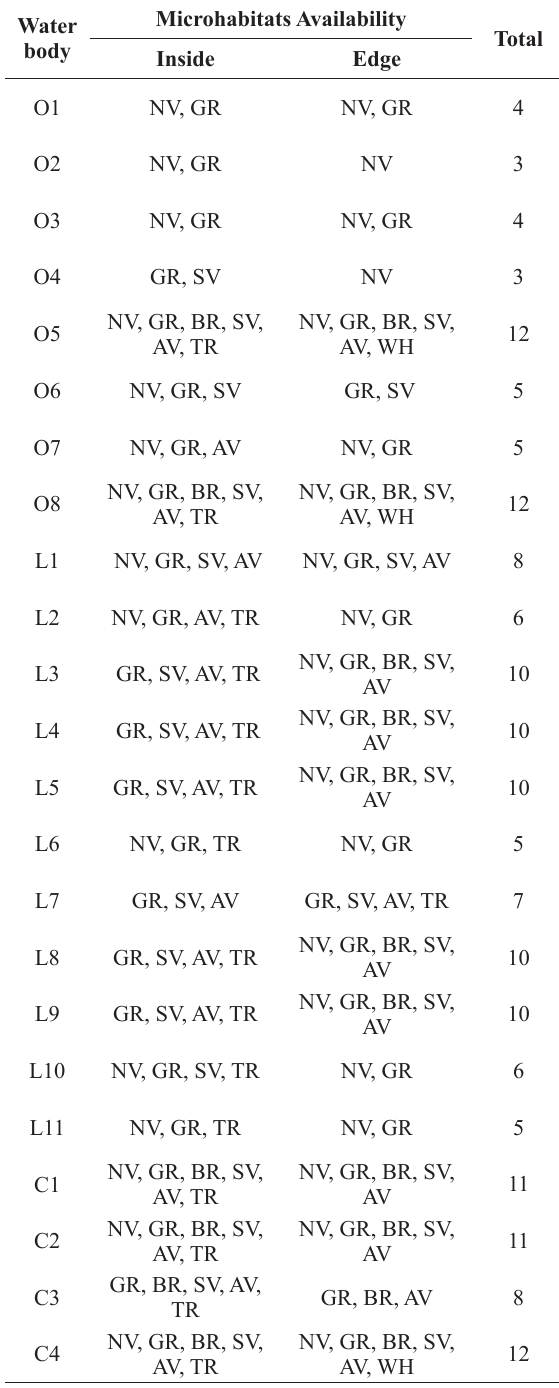
Microhabitats of the studied water bodies in southern Brazil. Microhabitats were: arboreal vegetation (AV), bulrushes (BR), grasses (GR), no vegetation (NV), shrub vegetation (SV), trunks (TR), and water hyacinths (WH). L = Londrina; O = Ourinhos; C = Cornélio Procópio. Water